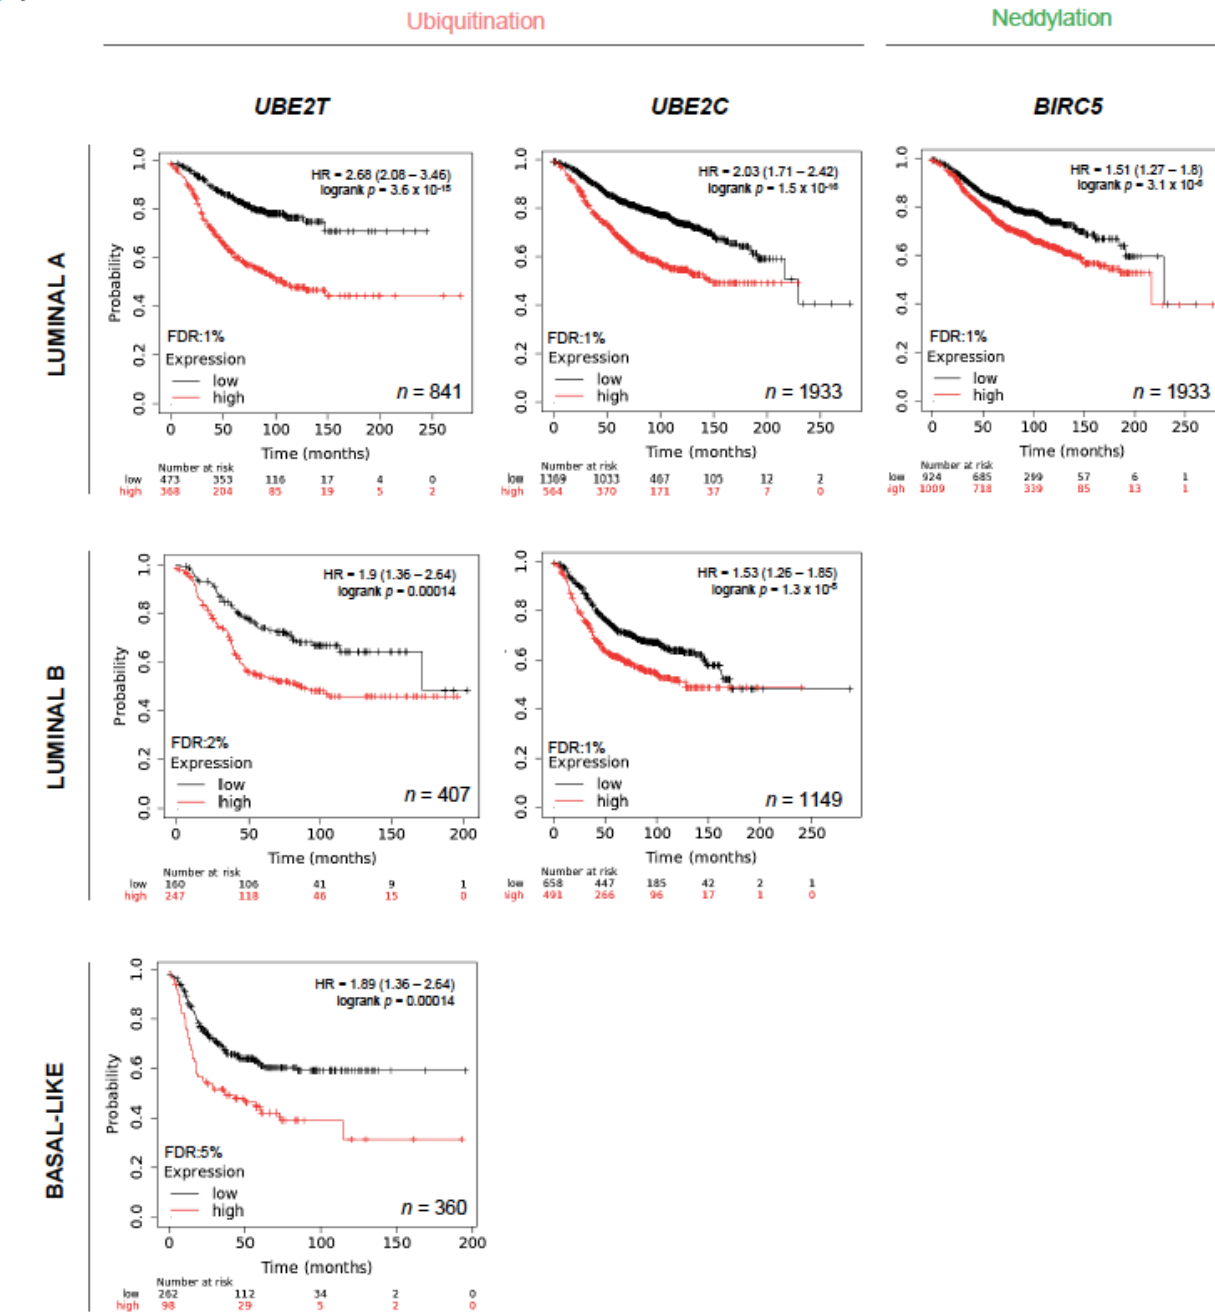
Figure 5. Association between gene expression and a worse relapse-free survival across intrinsic subtypes of breast cancer. ( a ) Filtering of gene amplifications with prognostic capability using the following criteria: statistical significance p < 0.05, FDR < 5%, HR of RFS > 1.5. ( b ) Survival analysis for the selected genes correlated with poor relapse-free survival across different intrinsic subtypes of breast cancer.